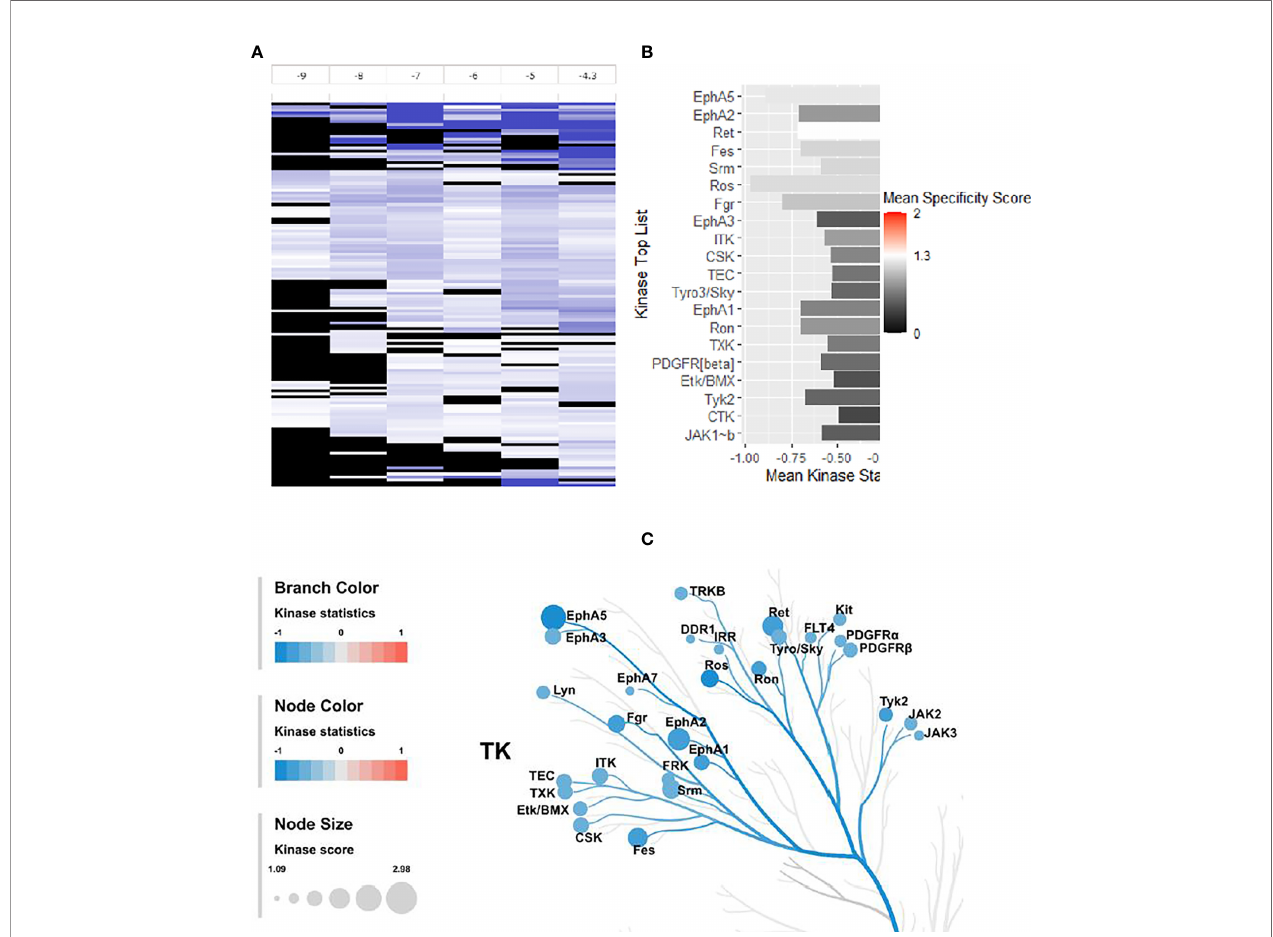
FIGURE 7 | Effect of 4e (0.1 µM) on the 144 YKs loaded on the Pamgene ’ s PamChip. (A) The LFC heatmap for 144 peptides shows the values of differentially inhibited phosphorylated peptides (treatment vs. DMSO control). The treatment effects are log-ratios (log2(treatment)-log2(control)). Black color are peptides which did not pass the threshold of inhibition. DMSO conc. 2% v/v; Compound concentrations: log -9 = 0.001 m M, log -8 = 0.01 m M, log -7 = 0.1 m M, log -6 = 1 m M, log -5 = 10 m M and log -4.3 = 50 m M. (B) Mean Kinase Statistic (represented by bar length) and Mean Speci fi city Score (represented by color scheme) for the top twenty affected YKs. (C) Kinome Tree: Top predicted kinases are represented on phylogenetic tree of the human protein kinase family. Size of dot indicates total kinase score, and color denotes kinases statistics (Red: higher in on-chip treated lysates, Blue: lower in on-chip treated lysate). Kinase score cut-off ≥ 1.2 was applied to select top altered kinases. Note that a fi le containing all kinase score above 0.0 at different concentrations can be found in Supplementary Material fi le